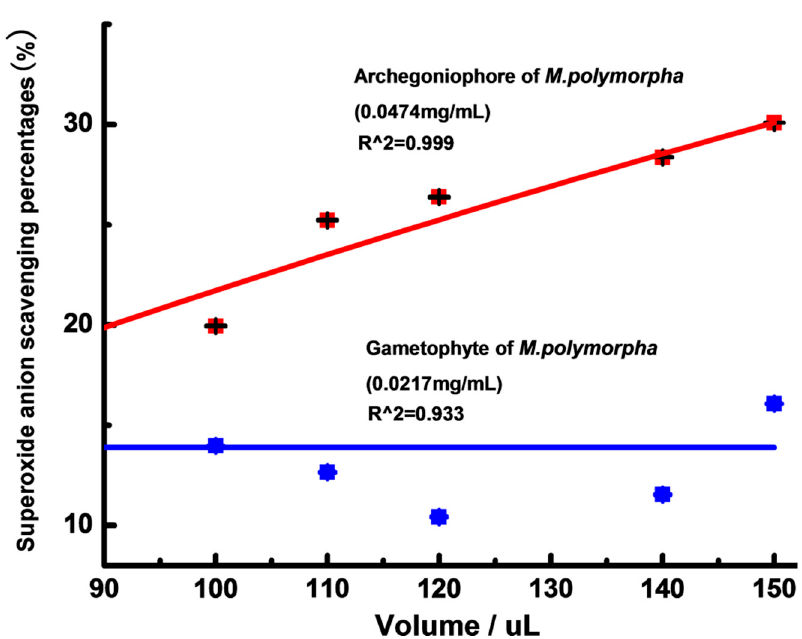
Figure 4. The superoxide anion scavenging potential of gametophyte and archegoniophore of M. polymorpha L . ( n = 3).